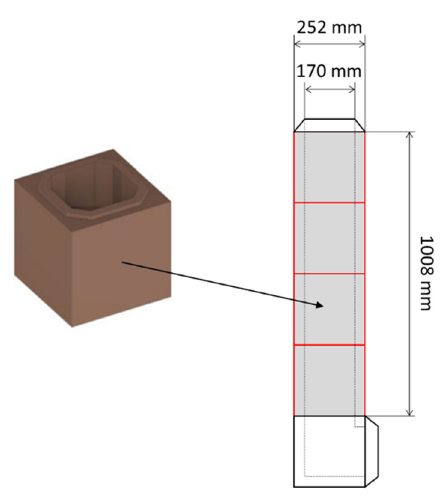
Figure 2. The main geometrical parameters of the tested SAH. Table 3. The main parameters of the “akubet” material used in the tested SAH.